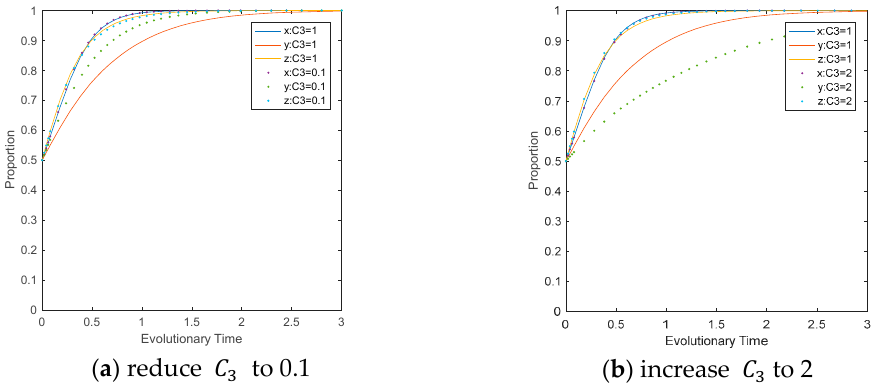
Figure 7. Impact of C 3 on the evolutionary path of multi-agents.